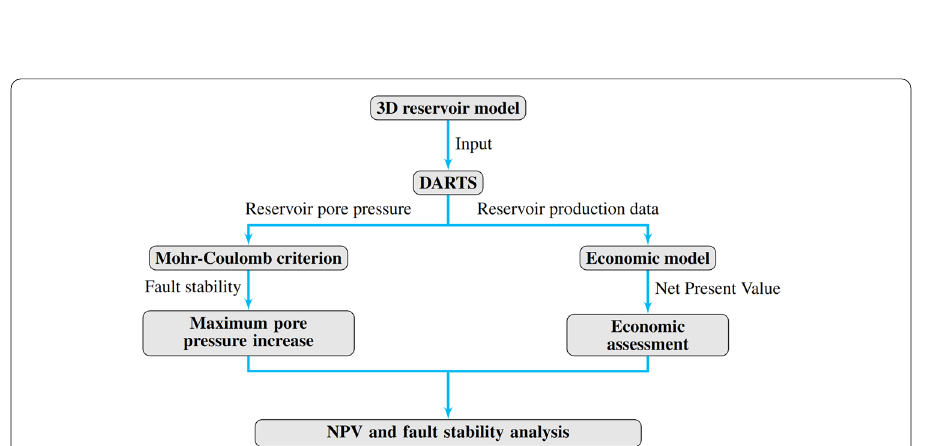
Fig. 2 Schematic of the analysis. Input data used are detailed in Table